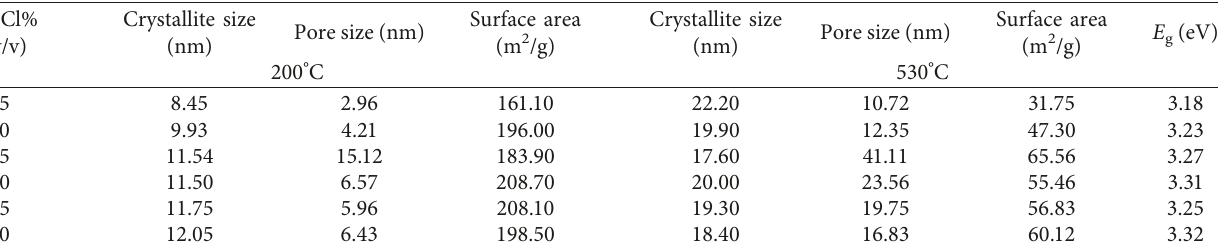
2m samples prepared in an autoclave at 200 ° C and at 530 ° C. g of TiO